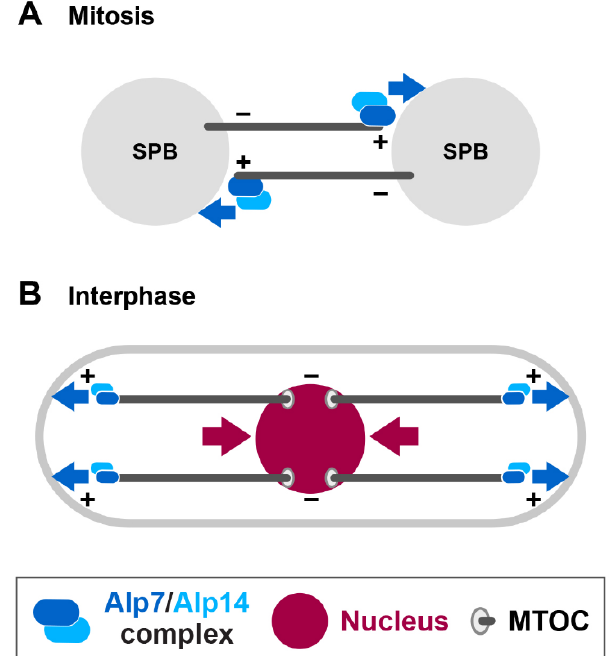
Figure 5. Force generation through microtubule polymerisation during interphase and mitosis. ( A ) During early mitosis, the Alp7/TACC-Alp14/TOG microtubule polymerase complex (blue ovals) is localised to the SPB (not shown) and the polymerising plus ends. Interaction of growing microtubule plus ends with the other SPB generates an outward force (blue arrows). This force is sufficient to separate the duplicated SPBs in the absence of Kinesin-5 and Kinesin-14, thereby promoting short bipolar spindle formation. ( B ) During interphase, the plus ends of the polymerising cytoplasmic microtubules reach and push the cell tip at either end (blue arrows), thereby pushing the nucleus through the opposite minus ends (deep red arrows). This allows positioning of the nucleus at the geometrical centre of the cell [91,92]. MTOC stands for microtubule organising centre, which is localised to multiple positions on the nuclear membrane during interphase [93,94]. + and – stand for the microtubule plus and minus ends, respectively.